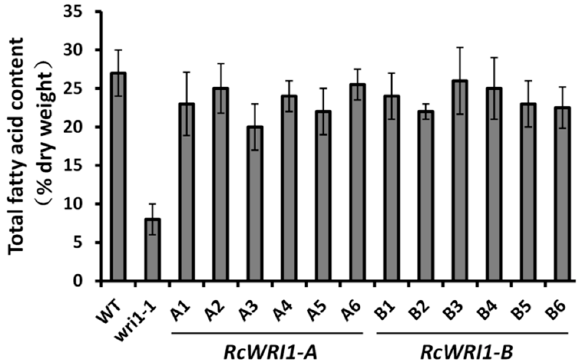
Figure 5. Total fatty acid content in seeds of Arabidopsis wildtype, wri1-1 mutant, and the mutants expressing either RcWRI1-A or RcWRI1-B . Total fatty acids were extracted from the seed and transmethylated, followed by gas chromatography analysis. Fatty acid content was expressed as the percentage of seed dry weight. Each value is the mean ± SD of six biological replicates.